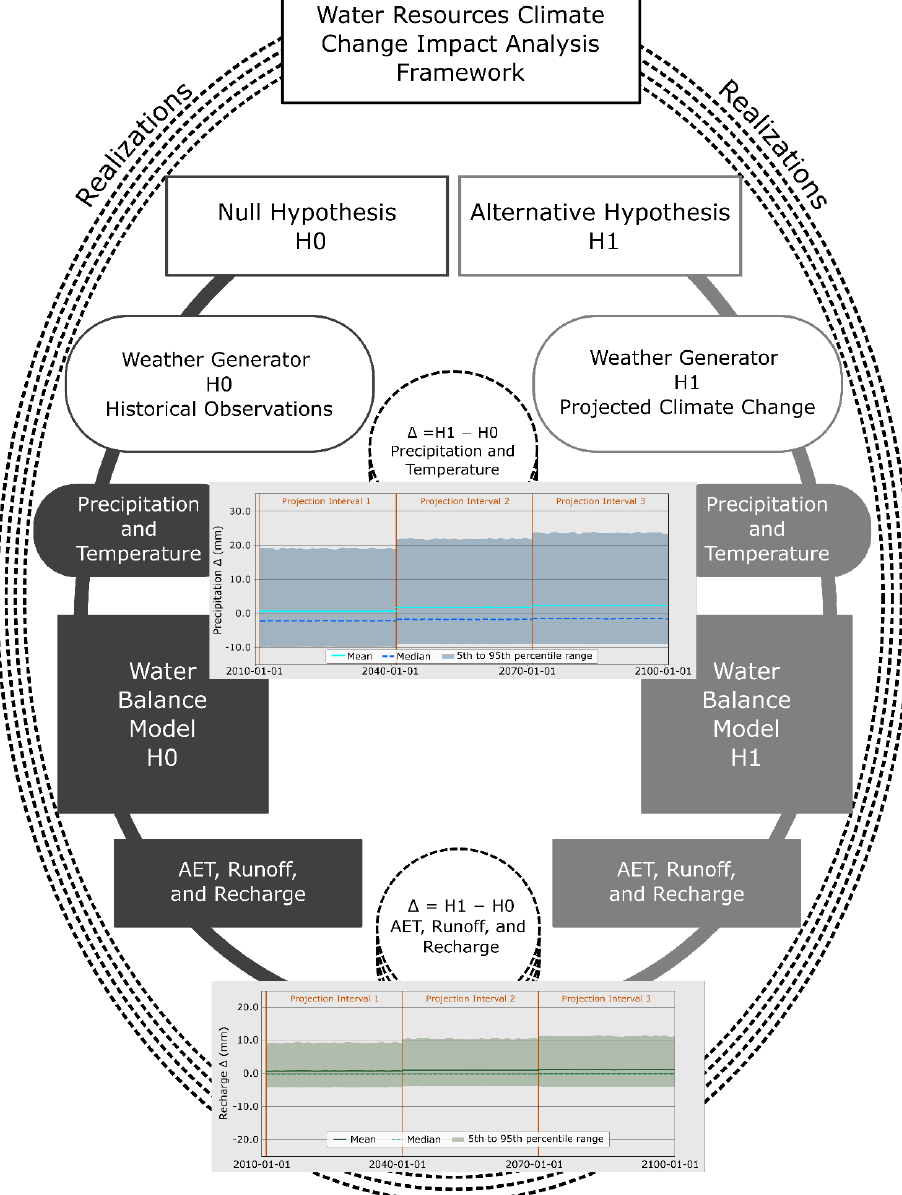
Figure 3. Climate change relative impact analysis framework for watershed-scale water resources. Framework results are presented in terms of the probabilistic difference, or Δ (Δ = H1 − H0), for simulated parameter values. Use of Δ values allows for isolation of impacts to water resources from future climate trends.